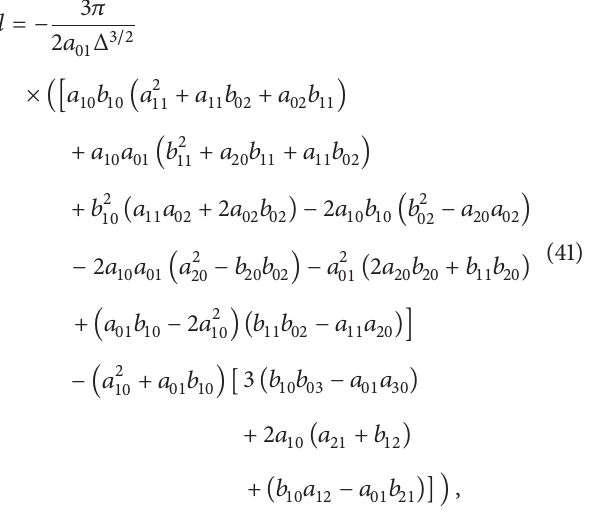
Figure 3. We need to require 𝛿 < 𝛿 1 (green line) and 𝛿 < 𝛿 2 (blue line) to guarantee the existence of 𝐸 2∗ ; that is, (𝐵1) and ) is a continuous increasing (𝐵2) hold (Figure 3(a)). tr (𝐽 2∗ function of 𝛿 . If 0 < 𝛿 < 𝛿 ℎ , system (7) has a stable 𝐸 2∗ (Figure 2(a)). As 𝛿 increases, a homoclinic loop is created by joining the stable and unstable manifolds of the saddle ̃𝛿 ̃𝛿 < 𝛿 𝐸 𝐸 ( 1∗ at some ℎ ) with a stable 2∗ inside (Figure 2(b)). Then as 𝛿 gets larger, an unstable limit cycle appears and coexists with a stable 𝐸 2∗ (Figure 4). However, the limit cycle begins to shrink with the increasing 𝛿 . The shrinking unstable limit cycle (Figures 3(b) and 3(c)) disappears as 𝛿 passes through 𝛿 ℎ (𝛿 ℎ is also the root of equation tr (𝐽 2∗ ) = 0 , = 0.009724) . Then 𝛿 < 𝛿 < 𝛿 𝐸 𝛿 ℎ ℎ 2 , 2∗ becomes unstable (Figure